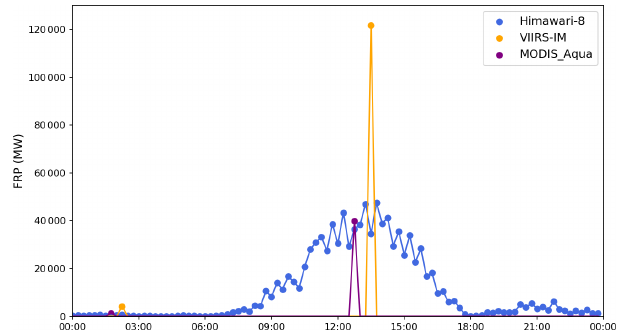
Figure 3. Time series of spatially summed FRP for eastern China, as retrieved from geostationary Himawari, and polar-orbiting VIIRS- IM and MODIS observations made on 11 June 2015. VIIRS and MODIS Aqua typically provide two observations per day, some- times three when swath overlaps from different orbits occur. Hi- mawari provides 144 observations per